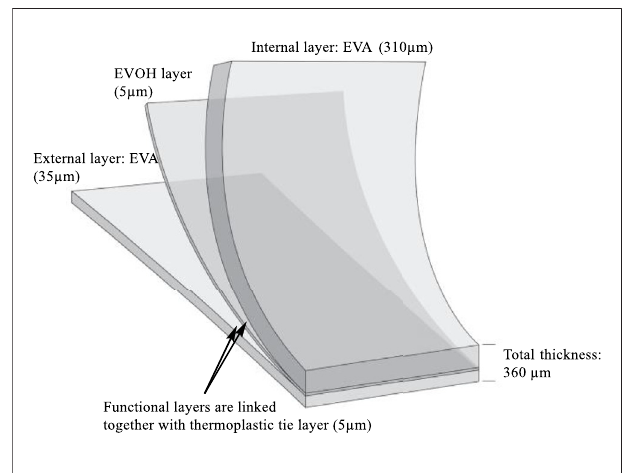
FIGURE 1 | Structure of the EVA/EVOH/EVA multilayer fi